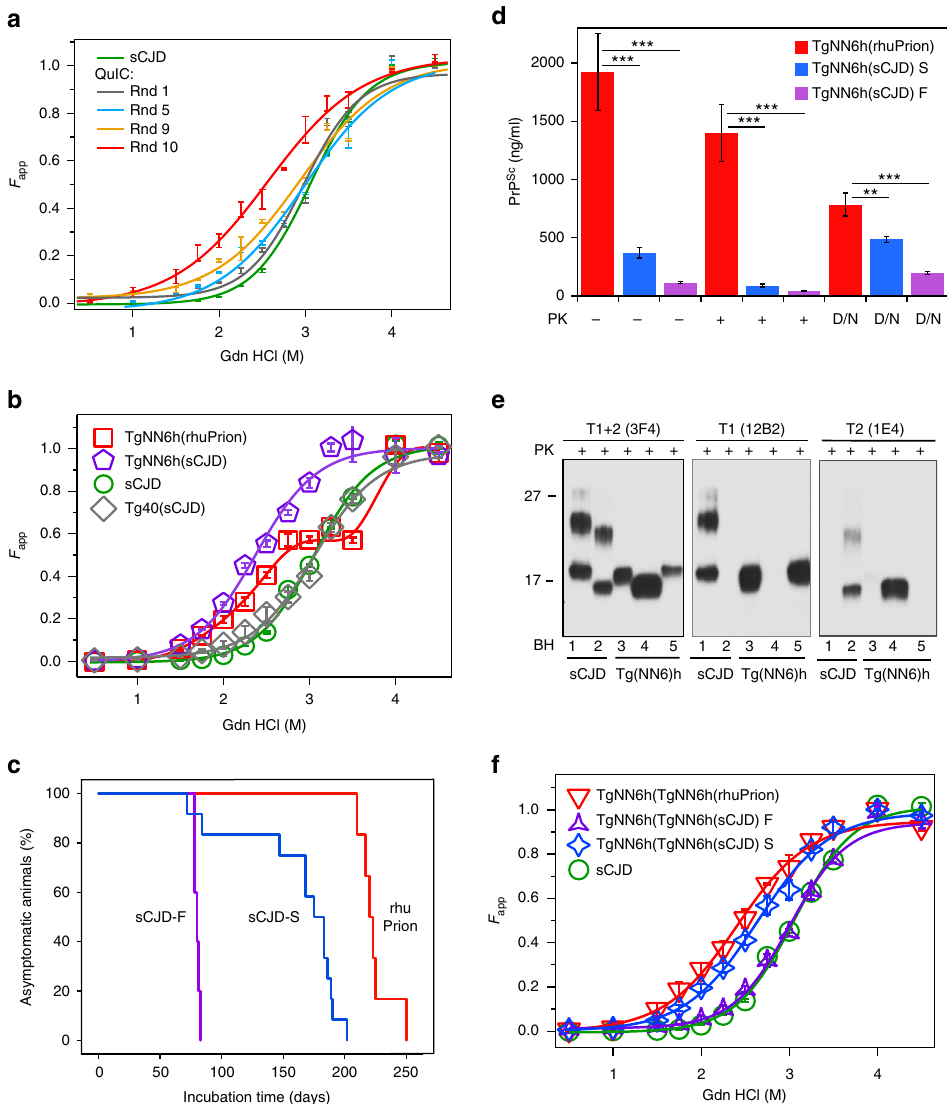
Fig. 2 Biochemical properties of rhuPrion. a Conformational stability of serial QuIC products. The reaction in the fi rst round (Rnd1) was seeded with brain- derived sCJD MM1 prions. b Conformational stability pro fi les of rhuPrion and sCJD prions after the fi rst passage in TgNN6h or Tg40 mice. c Survival curves of rhuPrion, sCJD-S, and sCJD-F prions in the second passage in TgNN6h. d Levels of total PrP Sc , protease-resistant PrP Sc , and D / N ratio using CDI assay of brain homogenates upon the second passage of different prions in TgNN6h mice. e Western blots of prion isolates probed with antibodies detecting both Type 1 and Type 2 PrP Sc (3F4) and antibodies speci fi c for Type 1 (12B2) or Type 2 (1E4) PrP Sc : lane 1 — MM1 sCJD; lane 2 — MM2 sCJD; lane 3 — rhuPrion; lane 4 — sCJD-F prions; lane 5 — sCJD-S prions. f Conformational stability pro fi les of the original human brain-derived sCJD, rhuPrion, and sCJD prions